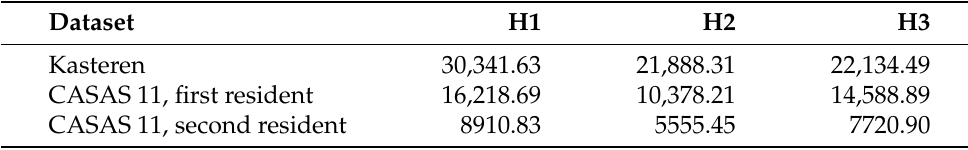
Table 3. Average Hamming distances between consecutive